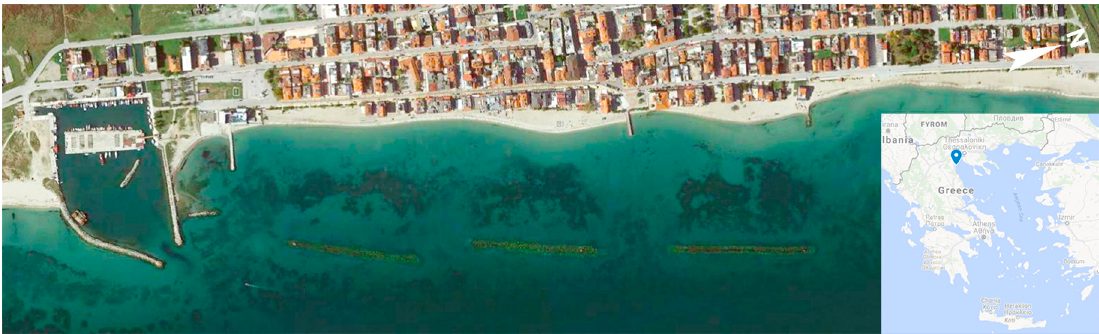
Figure 1. Location and satellite image of the study area at Paralia Katerinis, Greece ([47]; privately processed). Table 2. Characteristics of the three representative waves used for the Paralia Katerinis beach runs.